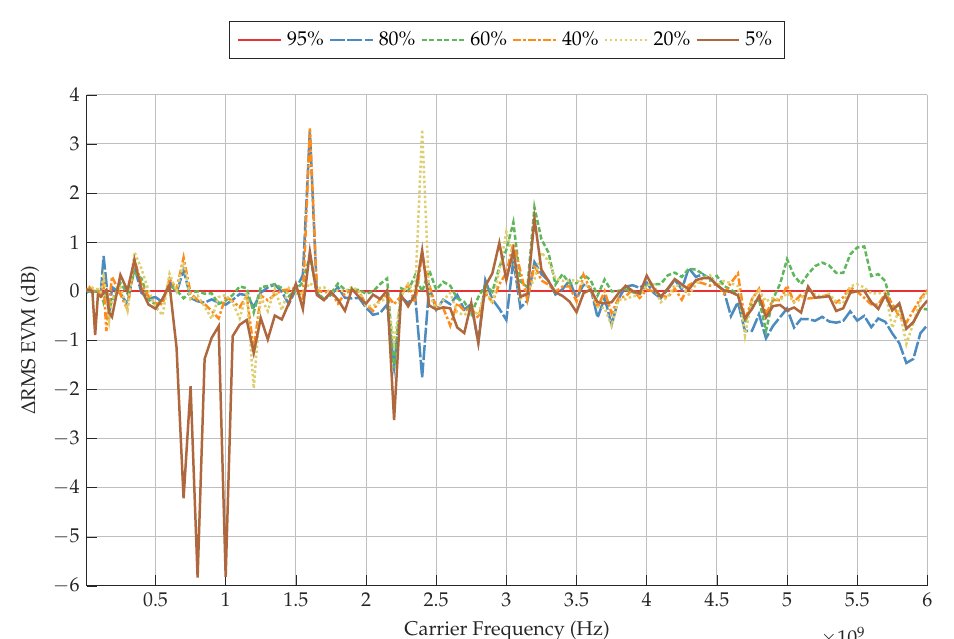
Figure 12. Change in RMS EVM of 4-QAM with SoC, using 95% SoC as a baseline. The next peak in EVM occurs at 1600 MHz for all SoCs, reaching an absolute value of 43.0 dB. Figure 12 shows that relative to 95% SoC, 40% SoC has the greatest EVM at − this peak, whereas 95% SoC has the lowest EVM. At this frequency, a correlation can be observed with the gradual minima occurring in S21 magnitude and a peak in negative phase shift, relative to their